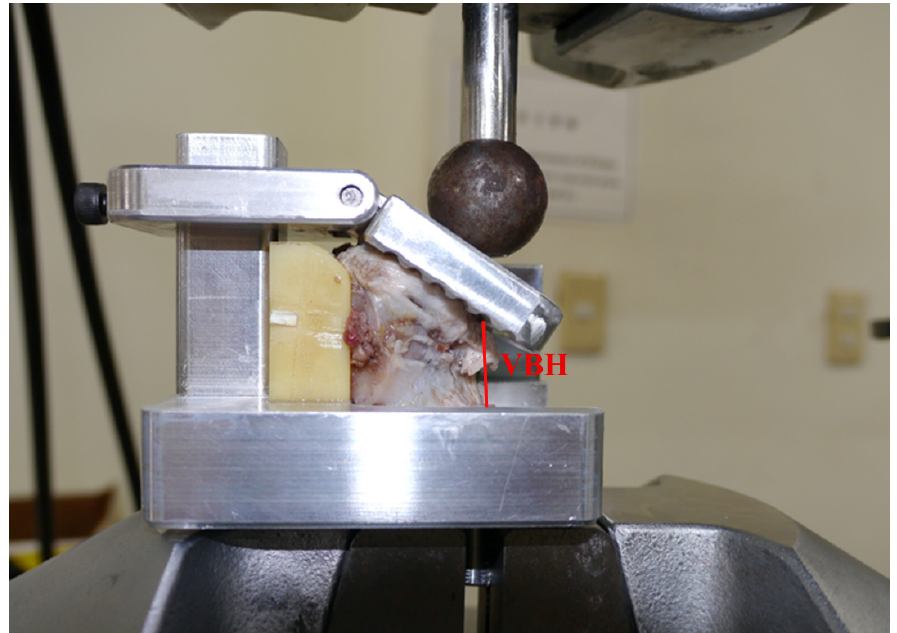
Figure 1. Photograph showing the experimental setup of the compression test. The main vector of the axial force was centered at the end plate of the anterior fourth of the vertebral body to create wedge compression of the anterior vertebral body.